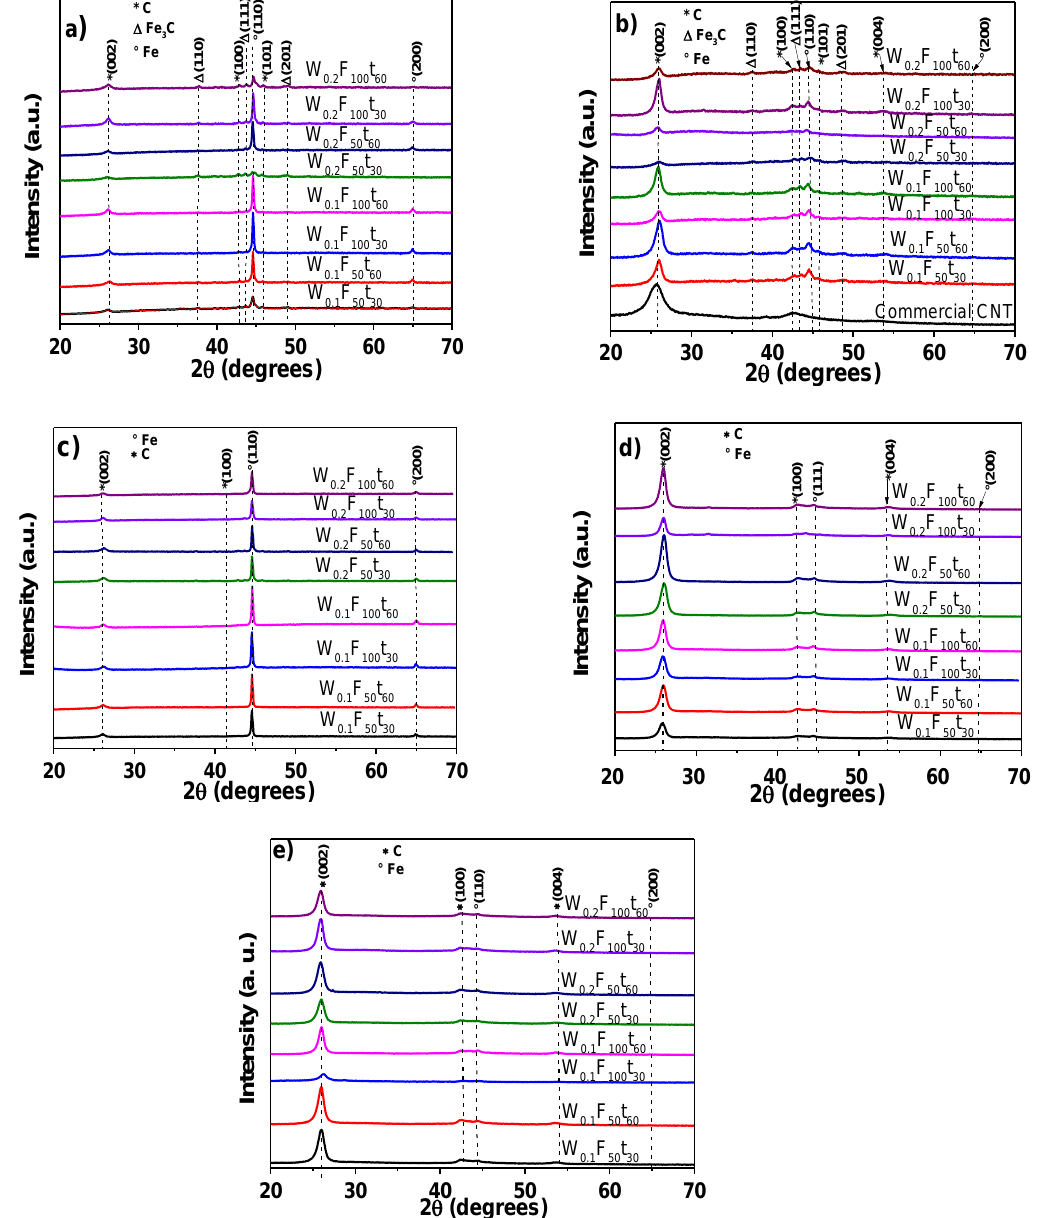
Figure 1. XRD patterns of MWCNTs obtained with different synthesis parameters at 1023 K ( a ) unpurified samples, ( b ) purified samples with HCl + H 2 O 2 solution. Samples synthesized at 1123 K ( c ) unpurified samples, ( d ) purified samples with HCl + H 2 O 2 solution, and ( e ) purified samples with HNO 3 + H 2 SO 4 . For all the samples, the XRD patterns were very similar, but an increase of 373